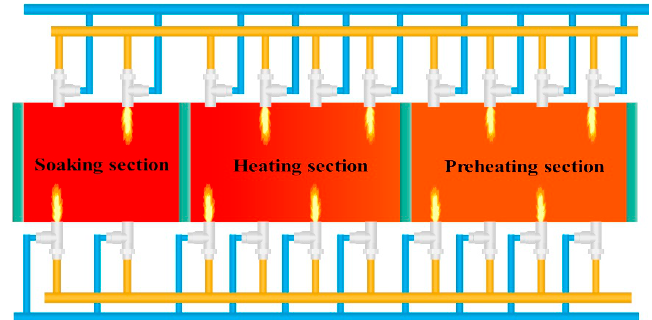
Figure 2. Heating process of heating furnace. The heating furnace is a three-stage heating furnace. The heating zones 1 to 4 are located in the preheating section, 5 to 8 in the heating section, and 9 and 10 in the soaking section.